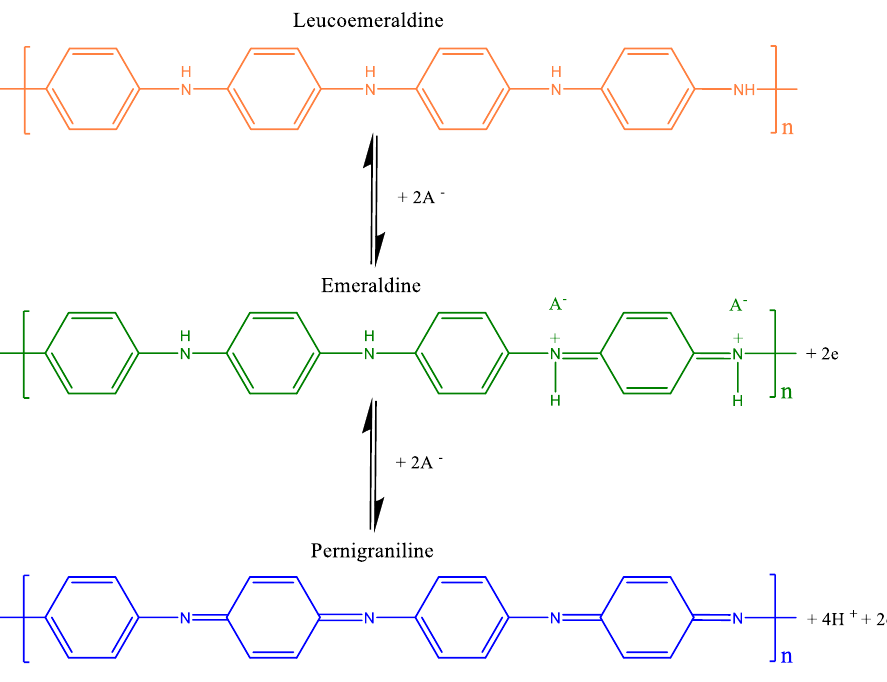
Figure 8. Redox transitions of the polyaniline.